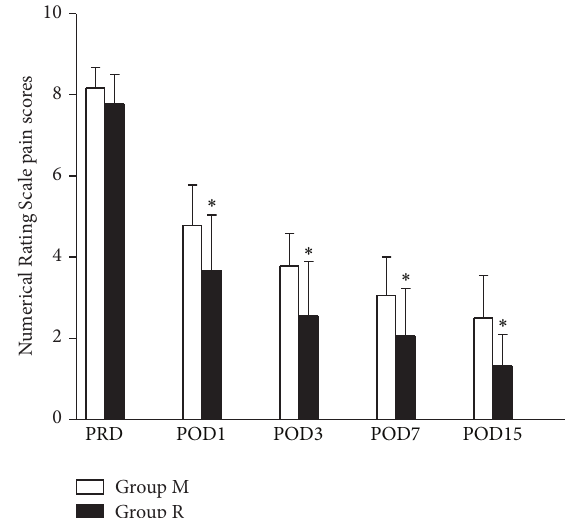
Figure 1: Numerical Rating Scale pain scores on pre- and postoper- ative days. Data are expressed as mean ± SD. ∗ 𝑃 < 0.01 compared to the group treated with morphine alone. PRD, preoperative day; POD, postoperative day.